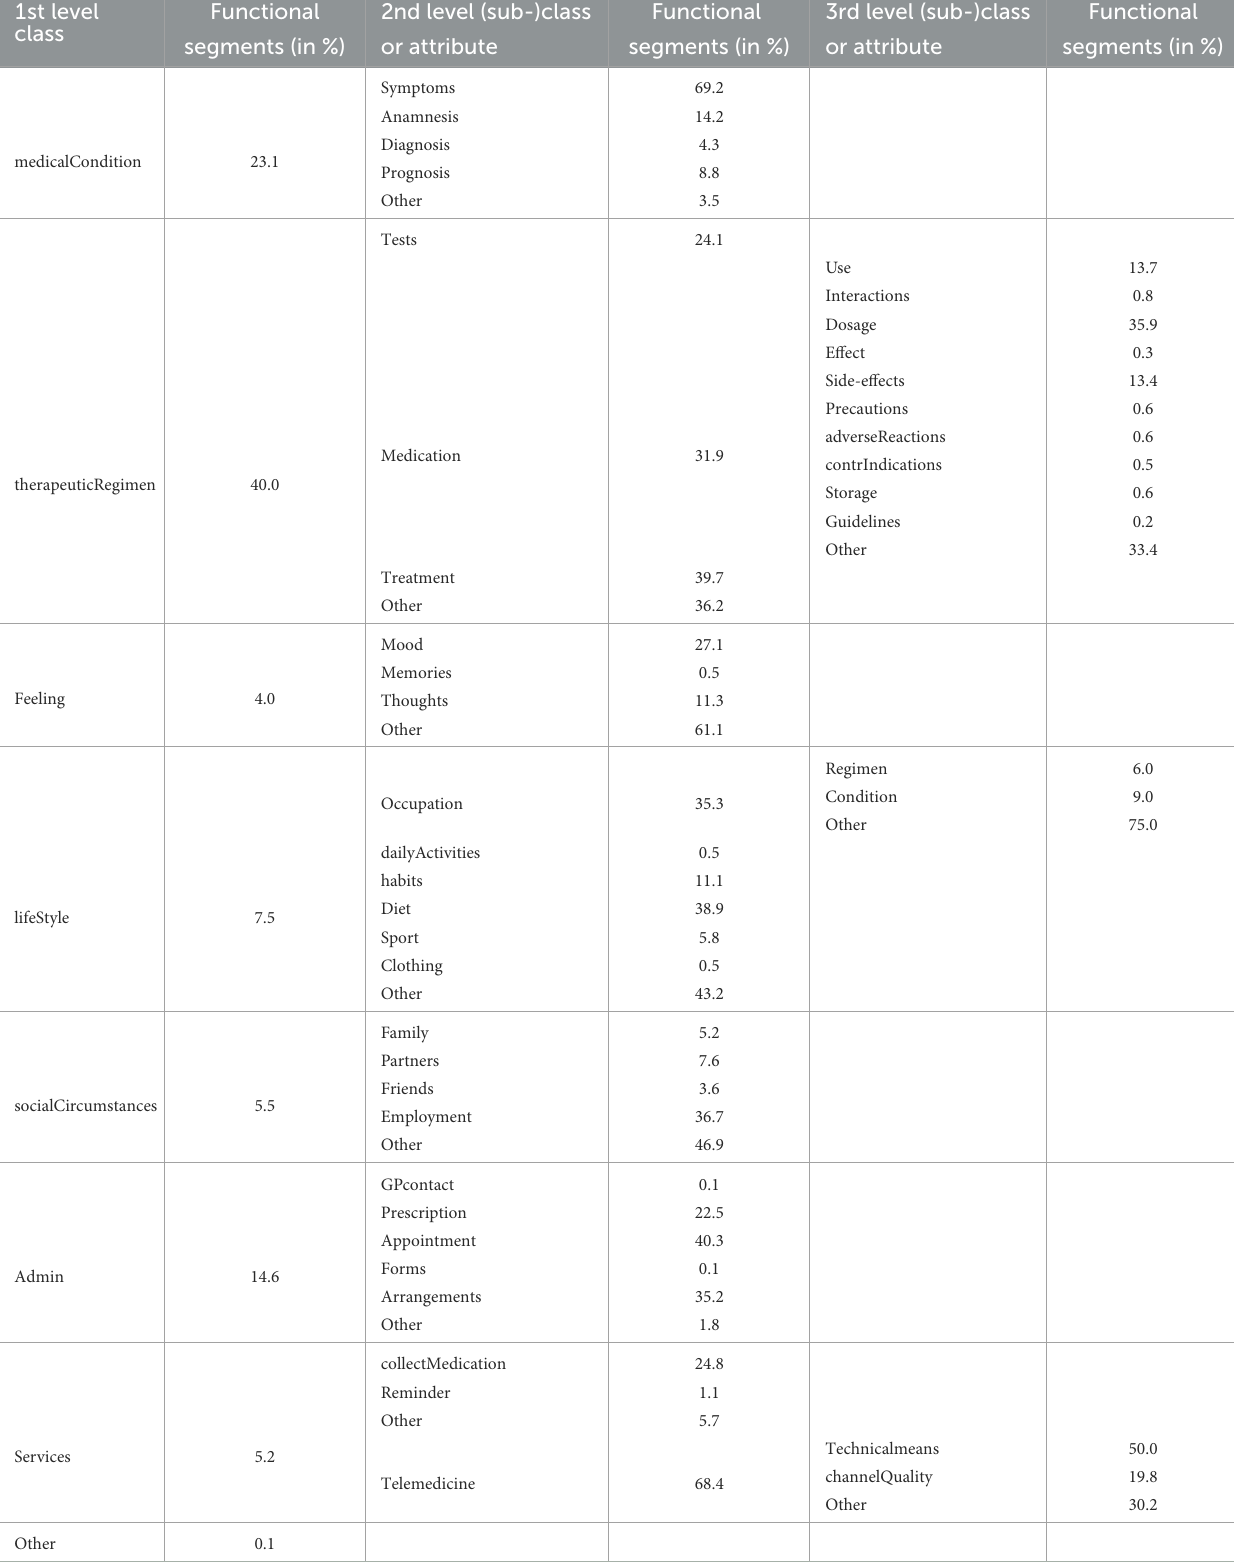
TABLE 4 Semantic content categories at multiple levels of